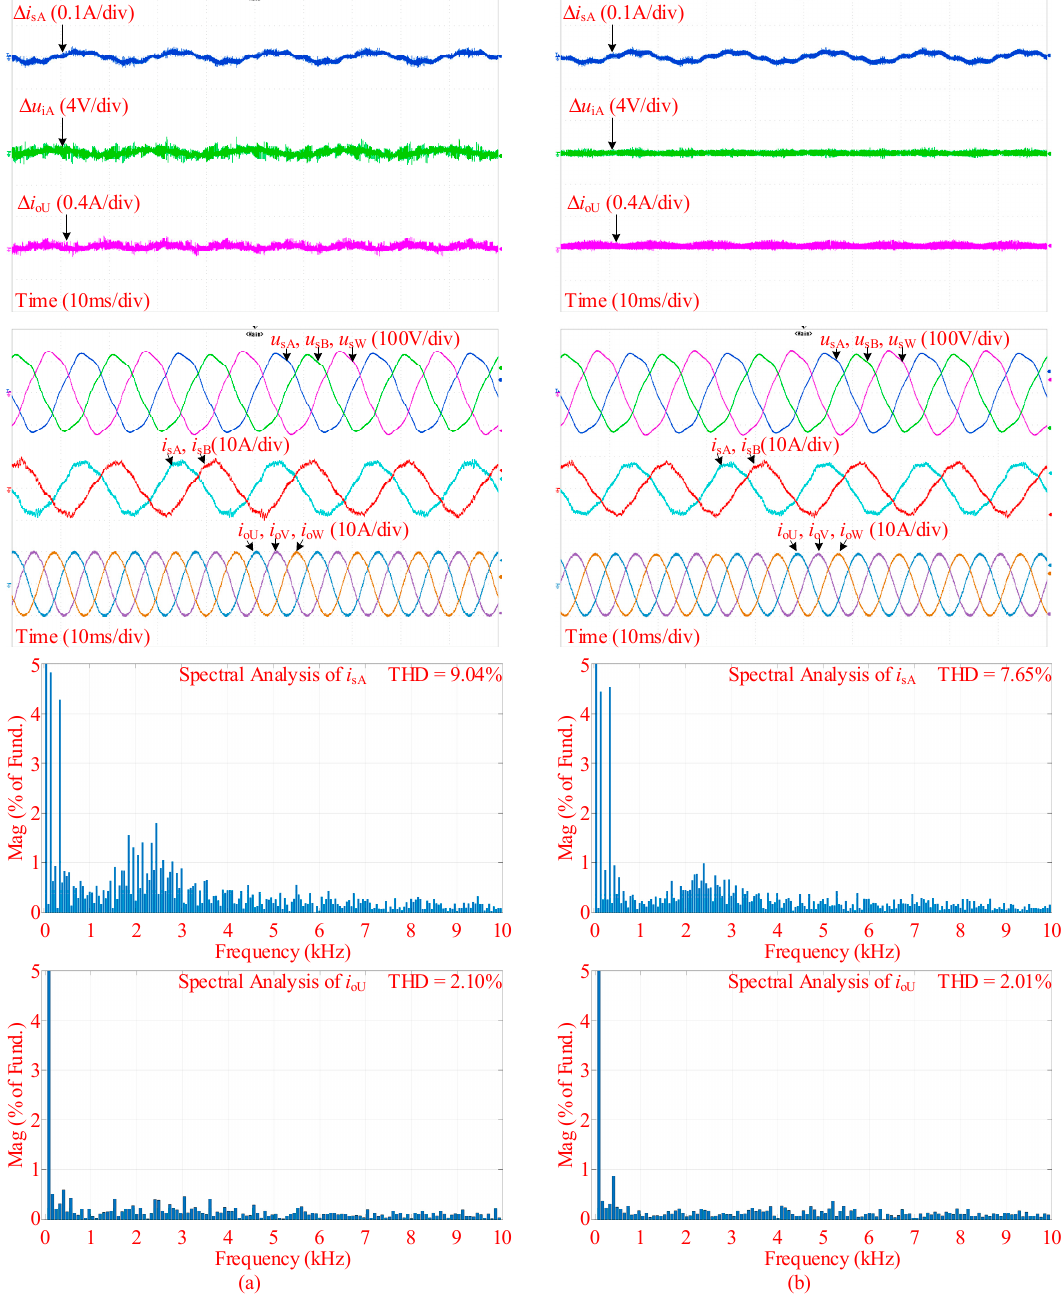
Figure 10. Experimental results of Case 5: ( a ) with the conventional MPC and ( b ) with the improved MPC. Source voltages are unbalanced and distorted.